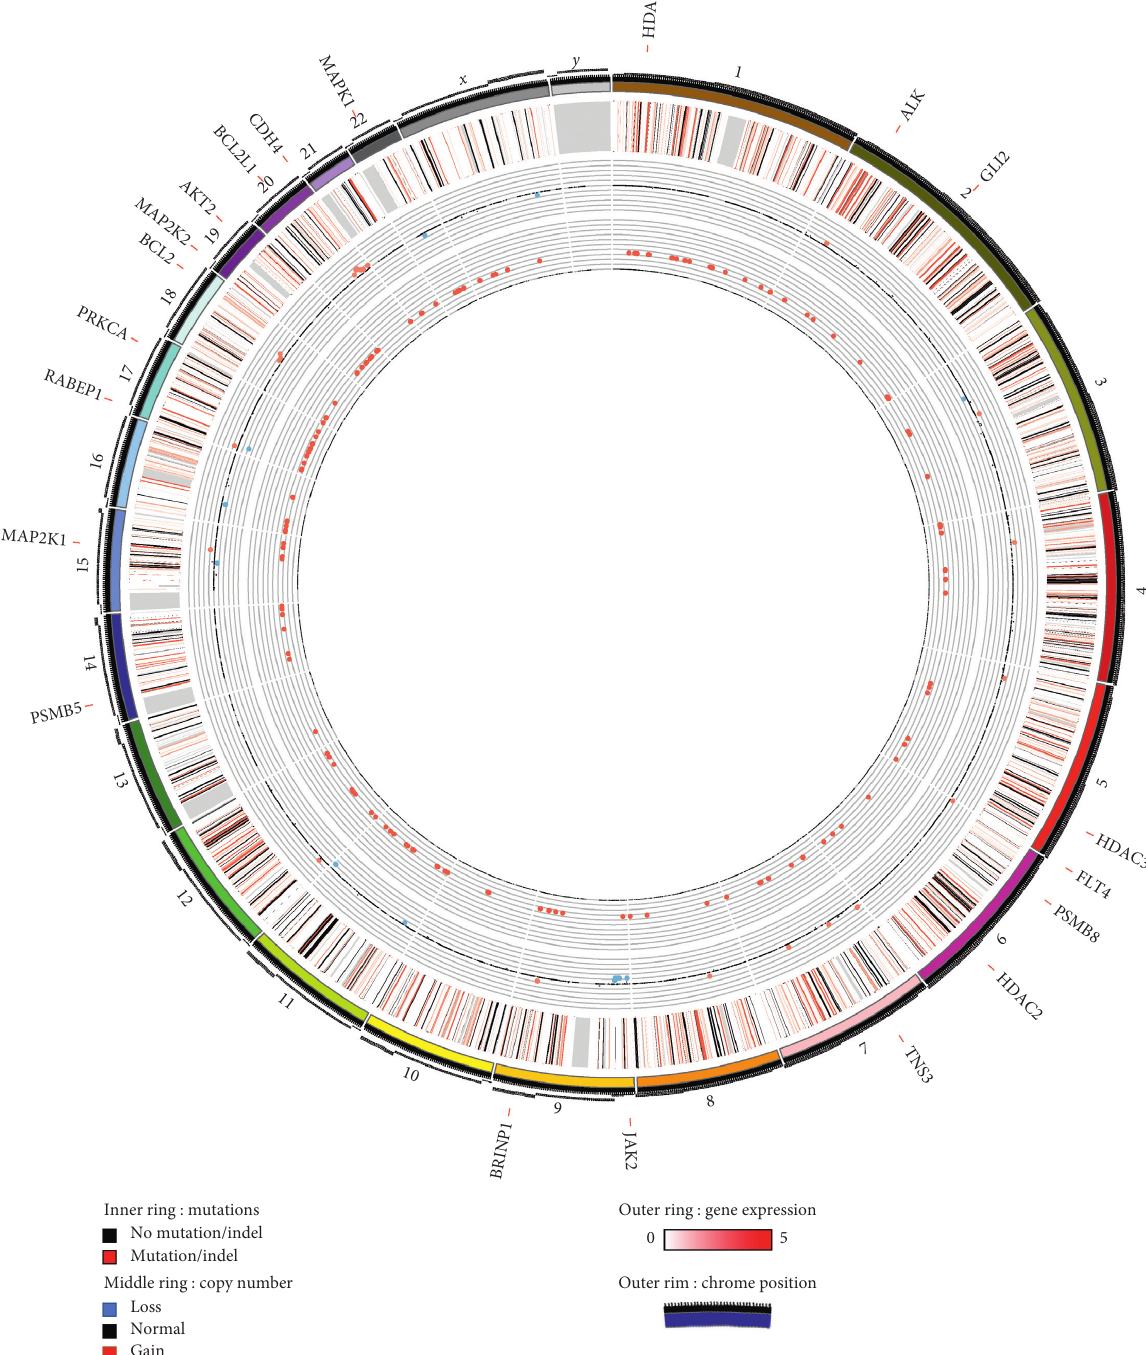
Figure 2: Circos plot of PCB-209 RNA sequencing and whole genome sequencing data. The outermost data circle represents log scaled gene expression (green represents negative, red represents positive) for genes with identified mutations or copy number variations. The middle circle represents genes with identified mutations or indels (black) or lack thereof (white). The innermost circle represents copy number variations (pink is amplification, light blue is deletion, and white is no variation). Genes which carry both mutations and amplifications ( TNS3 , BRINP1 , RABEP1 , and CDH4 ) are written in blue around the circle, as are genes relevant to in vivo studies ( HDAC1 , ALK , GL1 , HDAC3 , FLT4 , PSMB8 , HDAC2 , JAK2 , PSMB5 , MAP2K1 , PRKCA , BCL2 , MAP2K2 , AKT2 , BCL2L1 , and MAPK1